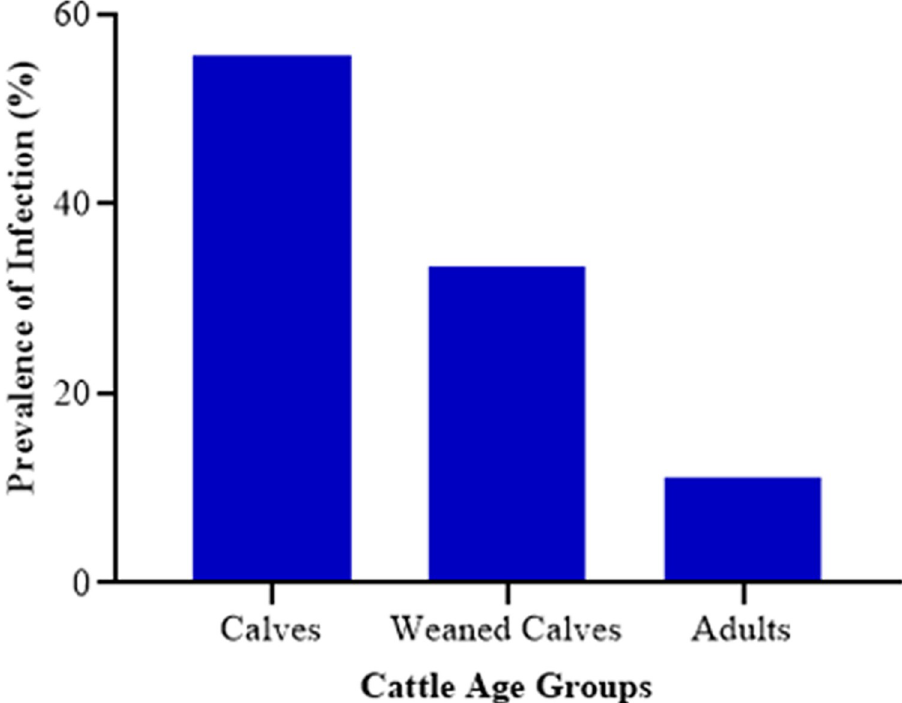
Fig 2. Distribution of Cryptosporidium sp . among the cattle age-group.